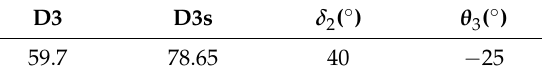
Table 1. The geometrical parameter values (mm).